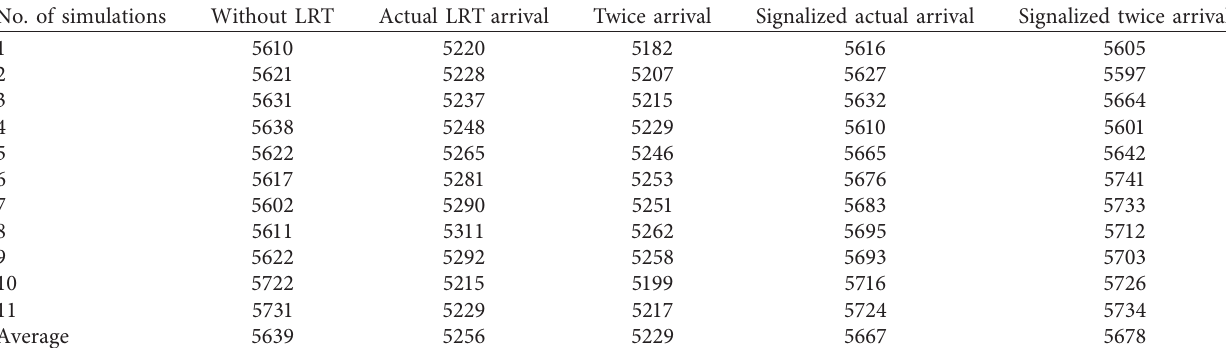
Table 2: CMC roundabout level crossing average volume of simulation